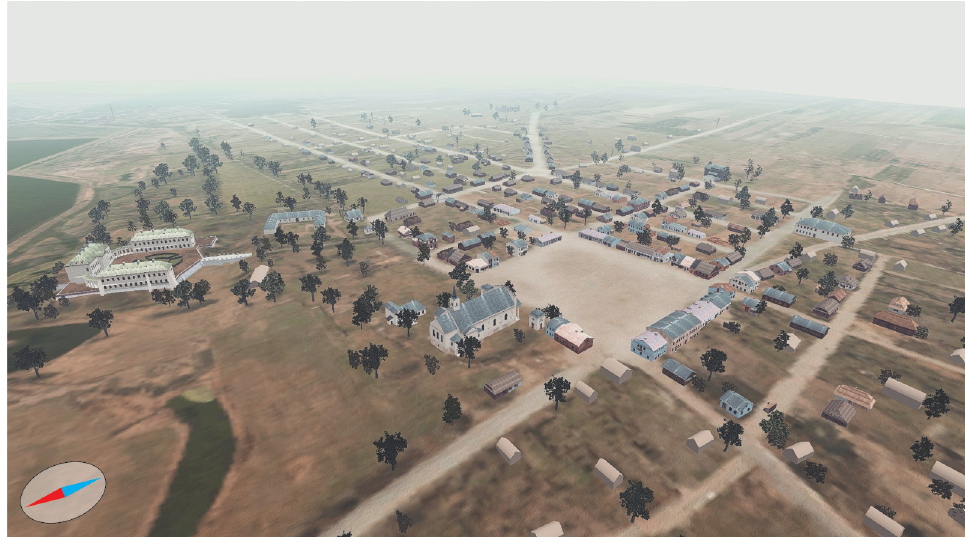
Fig. 4. Kock 1930s (Poland) – Shtetl Routes 3D mock-up (sample) (source: